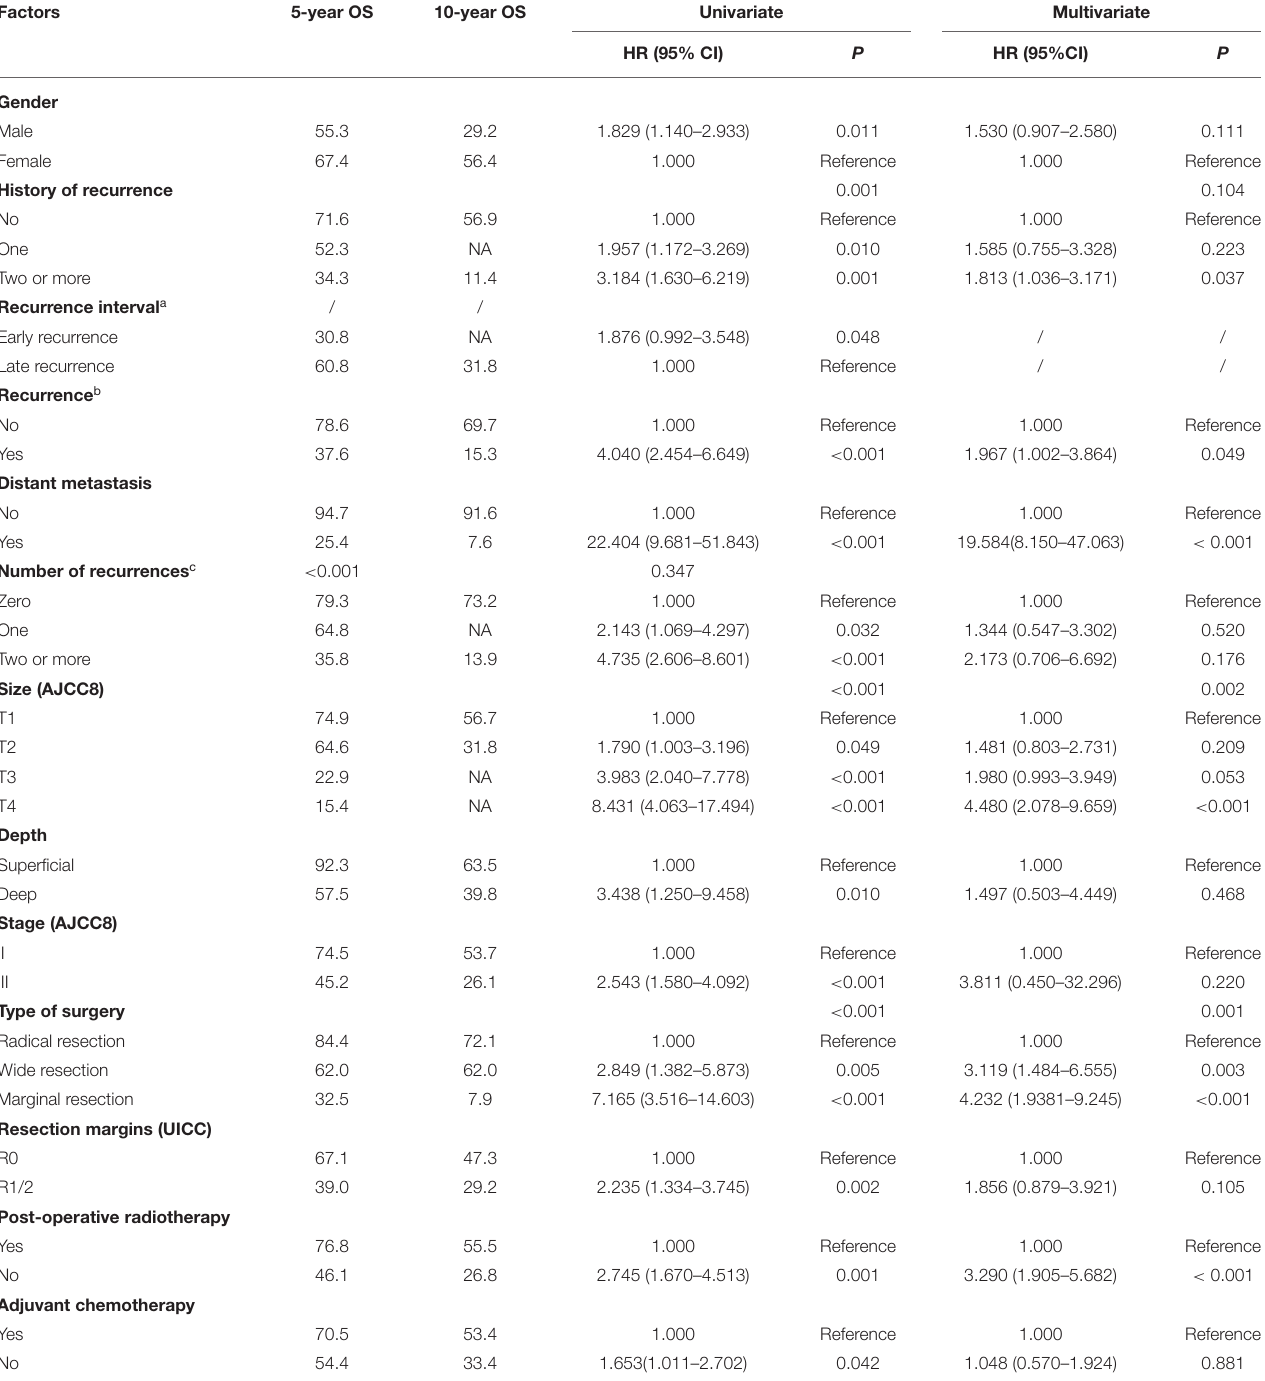
TABLE 2 | Univariate and multivariate analysis of variable factors and OS. Factors 5-year OS 10-year OS Univariate